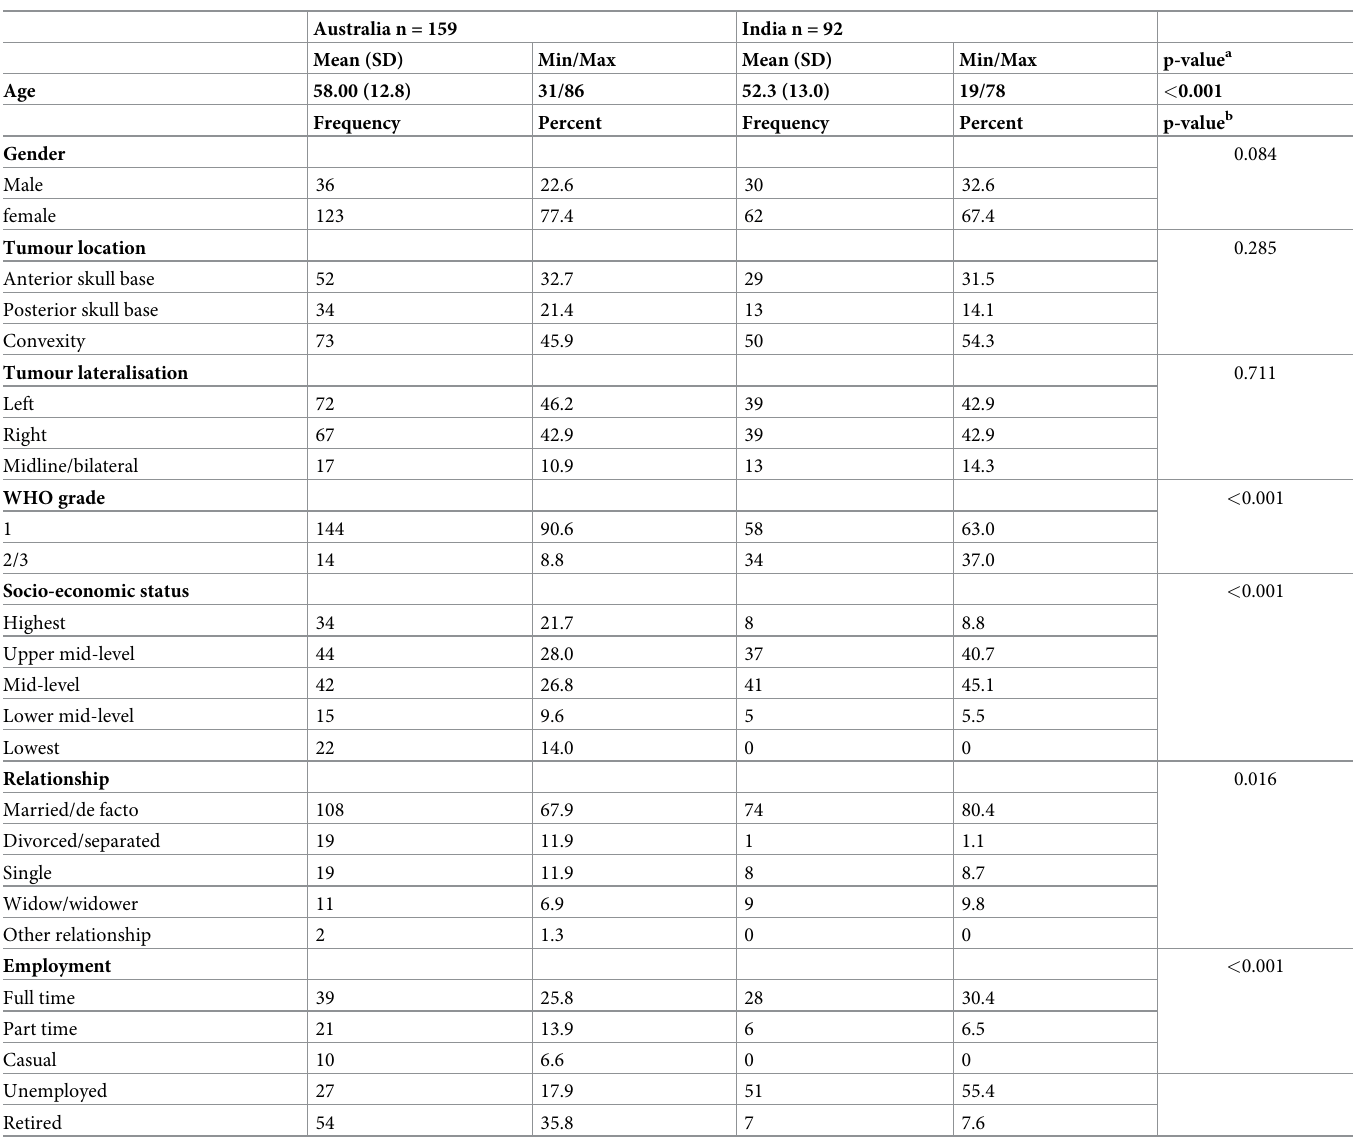
Table 1. Patient and tumour